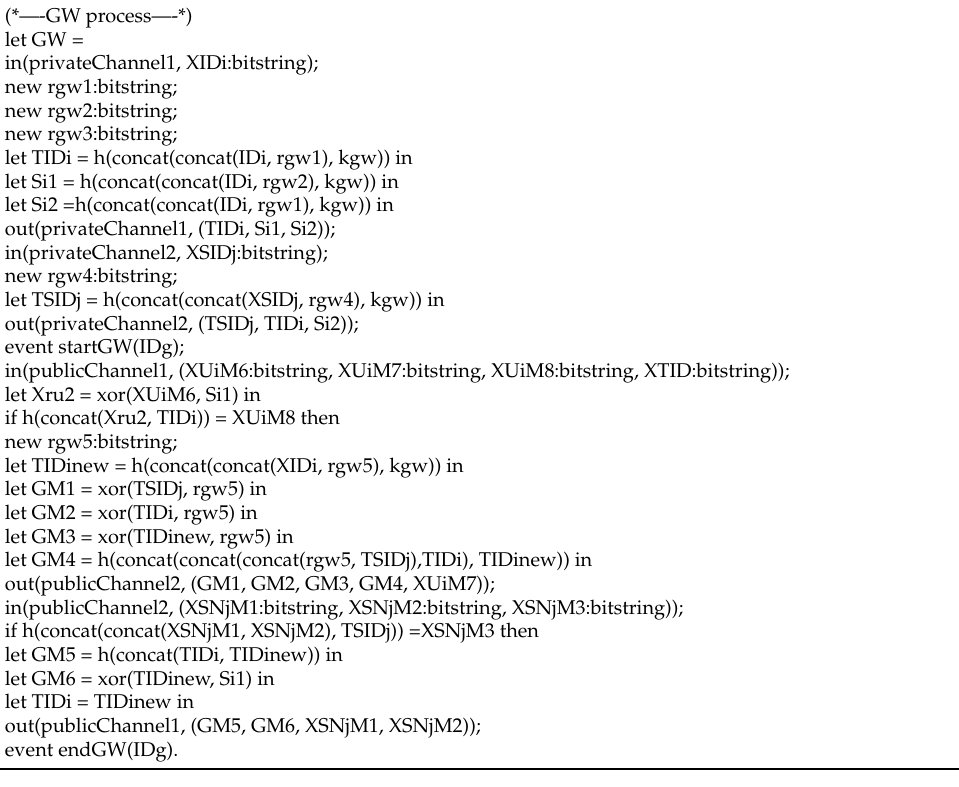
Table 7. Gateway’s process.